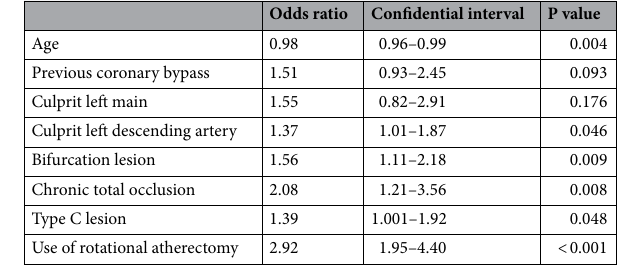
Table 3. Multivariable logistic regression model of the factor for contrast ≥ 200